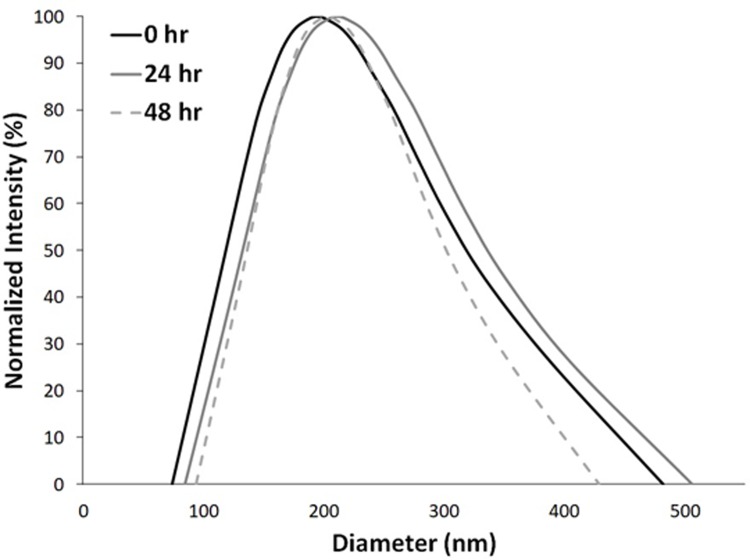
Dynamic light scattering measurements indicating minimal change in size distribution of AS1411-conjugated nanodroplets up to 48 hr.